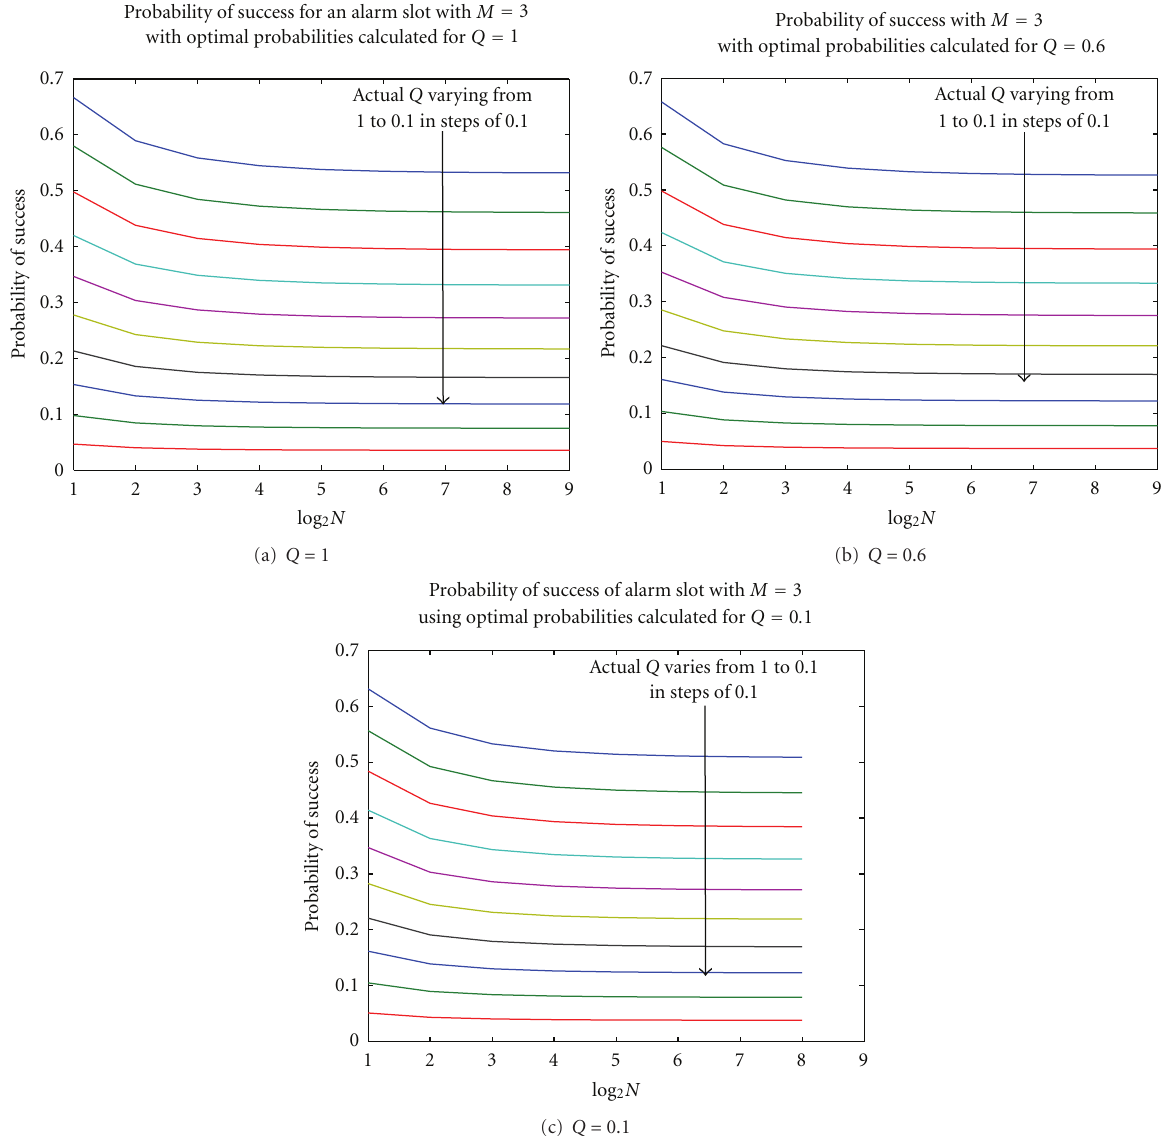
Figure 7: E ff ect of Q on which probabilities are calculated as a function of probability of success in an alarm slot.